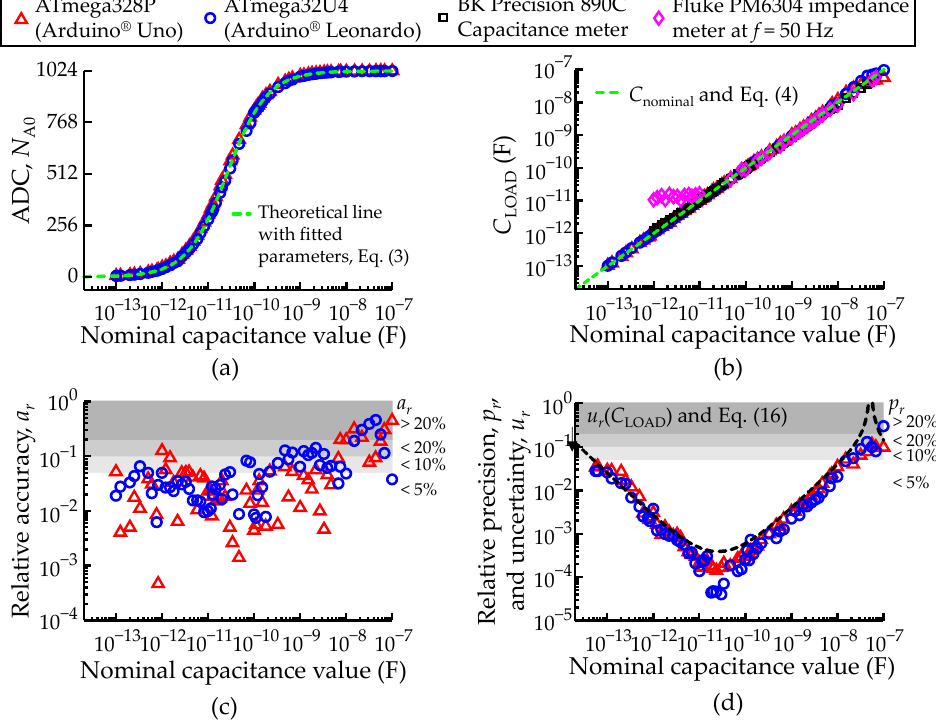
Figure 9. Comparison between the ATmega328P and ATmega32U4 AVR ® micro-controllers config- ured to record an isolated load capacitance ( C LOAD ) through the fast acquisition mode. ( a ) Measured ADC values at port P A0 ( N A0 ). Each ADC sample consists of an average of 100 consecutive mea- surements. ( b ) Measured load capacitance ( C LOAD ) given by Equation (4). The green dashed lines represent the theoretical lines. ( c ) Relative accuracy ( a r ) and ( d ) relative precision ( p r ) of the measure- ments in function of C nominal . The black dashed line represents the relative uncertainty ( u r ) of the C LOAD measurements according to Equation (16). The white and grey shading areas highlight the levels of u r , a r and p r better than 5%, 10% and 20%. A legend to describe the color scheme used in all plots of Figure 9 was